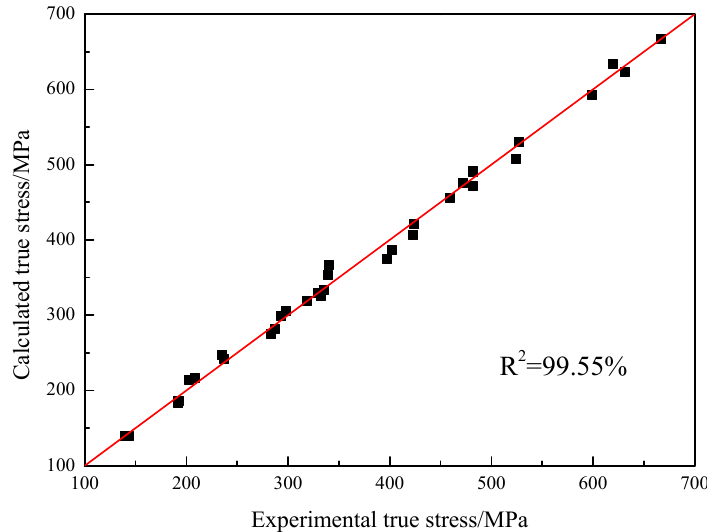
Figure 14. The comparison of calculated values and experimental results of true stress of JC-HS model.